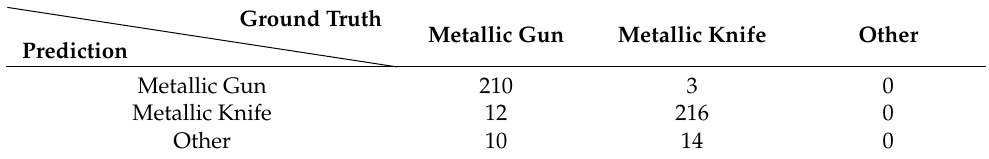
Table 7. Confusion Matrix of Threat Classification in Online